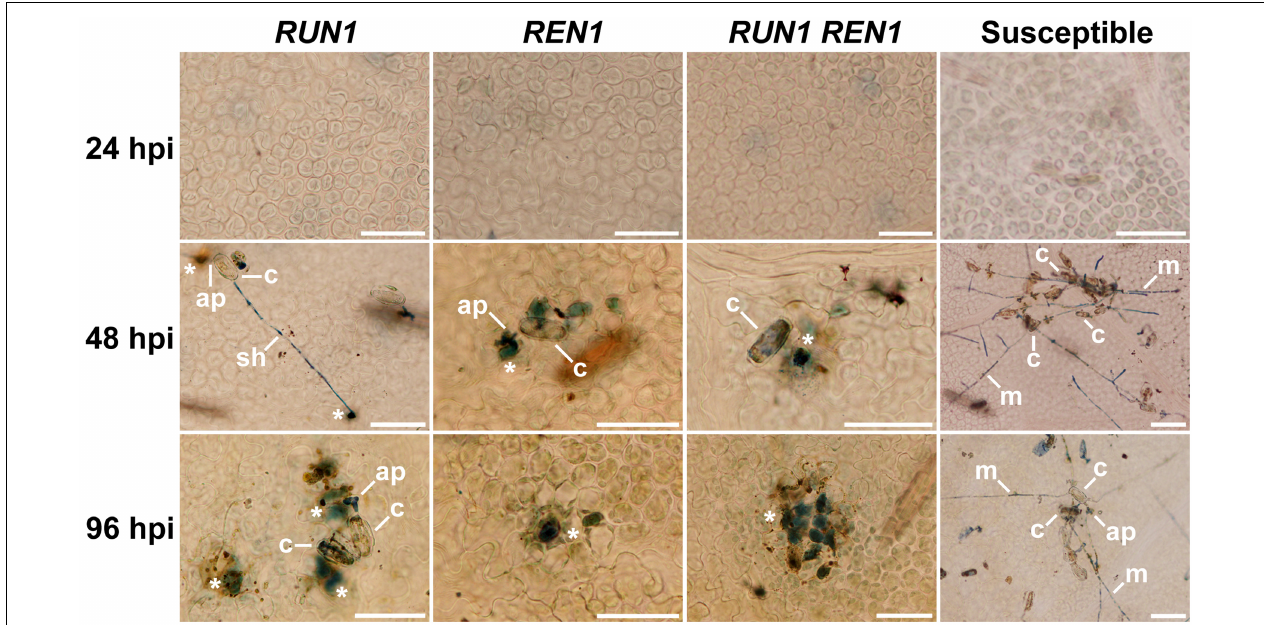
FIGURE 6 | Induction of programmed cell death (PCD) at the E. necator infection site in segregating grapevine plants carrying RUN1 and/or REN1 loci. Samples were collected at 24, 48, and 96 hpi; c, conidium; ap, appressorium; sh, secondary hypha; m, mycelium; asterisks indicate trypan blue-stained cells undergoing PCD in response to infection; scale bar, 50 µ m.